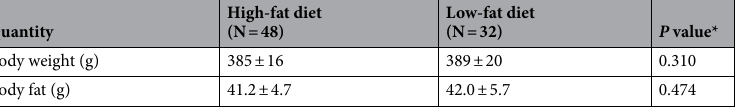
Table 2. Body weight and fat prior to dietary induction. Values obtained just prior to 6-month dietary induction phase. Data = mean ± SD; *unpaired t-test.